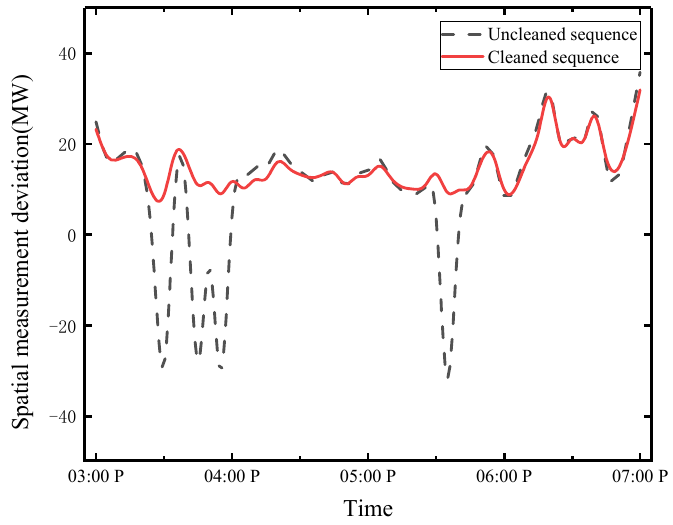
Figure 15. Comparison of the 30th sky interval measurement deviation before and after